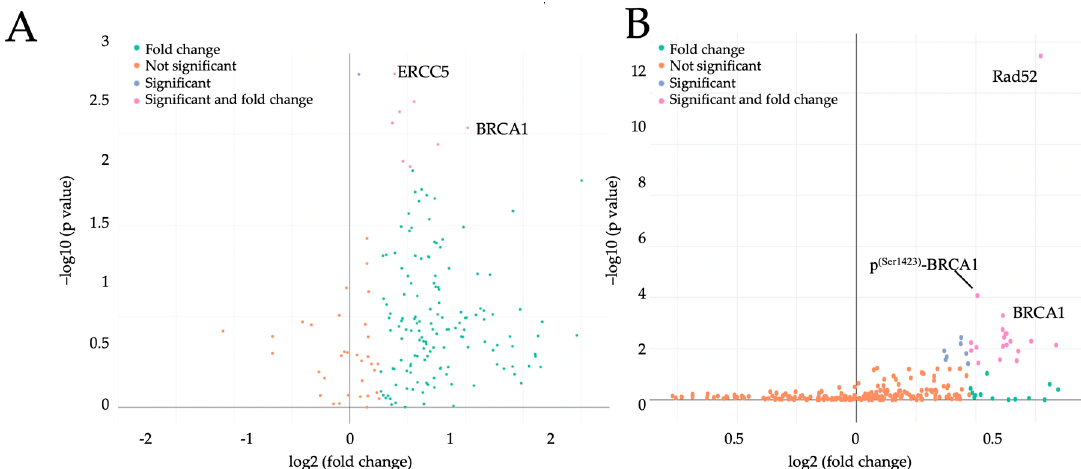
Figure 1. Induction of negative cell cycle regulators by maternal obesity in early pregnancy. Volcano plots show fold change for genes ( A ) and proteins ( B ) di ff erentially expressed between lean ( n = 7) and obese ( n = 6) placental tissue (gestational week 7). PCR panel and protein array results were analyzed through multivariate linear regression using BMI as exposure, adjusting for maternal age. Di ff erences were considered significant when p < 0.05 and the fold change threshold was set to 1.3. x axis = log2 fold change (lean versus obese), y axis = multivariate linear regression p value. Legend: BRCA1, breast cancer 1; ERRC5, excision repair 5; p (Ser1423) -BRCA1, phospho-BRCA1.